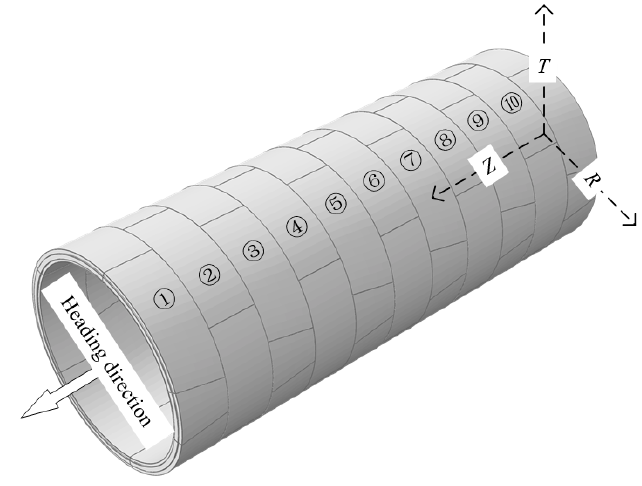
Figure 6. Tunnel coordinates.